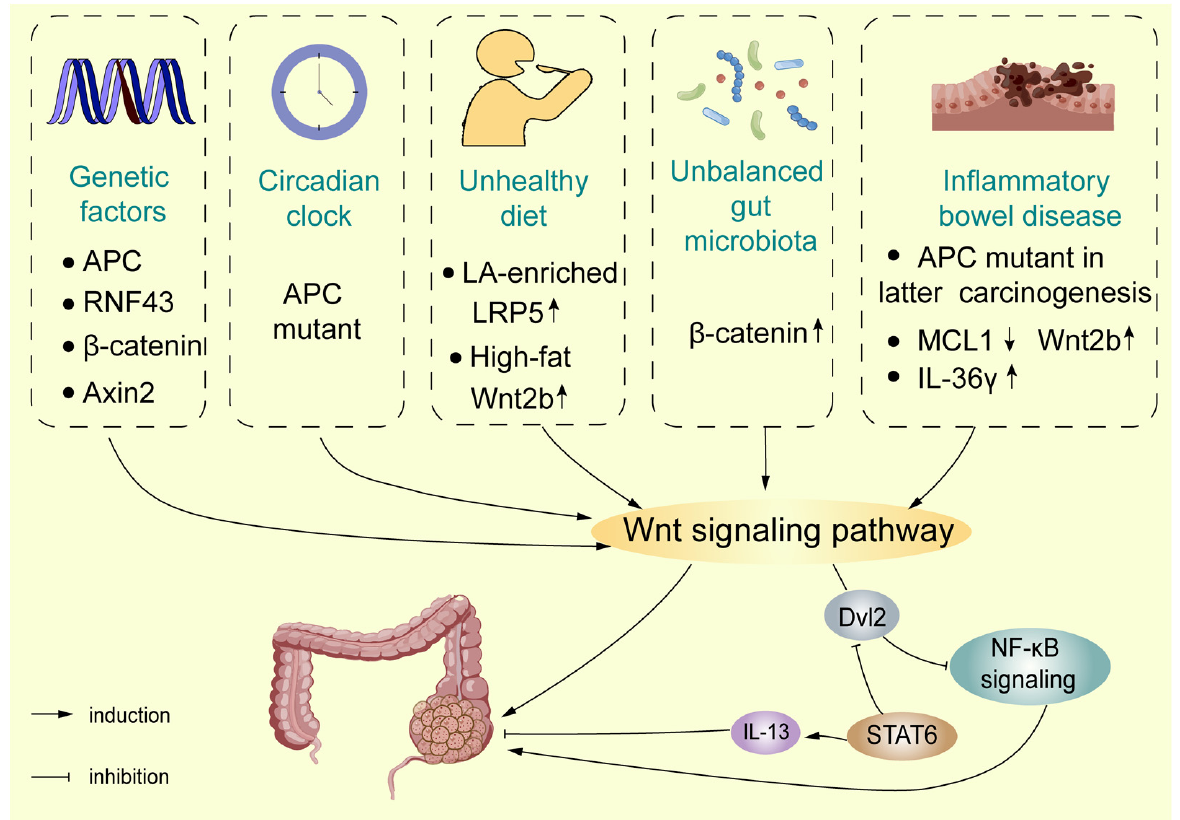
Figure 2. The Wnt signaling pathway in occurrence of colorectal cancer. Genetic factors, and environmental factors, such as unhealthy lifestyle, and imbalanced gut microbiota may induce colorectal cancer (CRC) by Wnt signaling pathway. Moreover, aberrant Wnt signaling pathway also play a crucial role colitis-associated carcinoma.